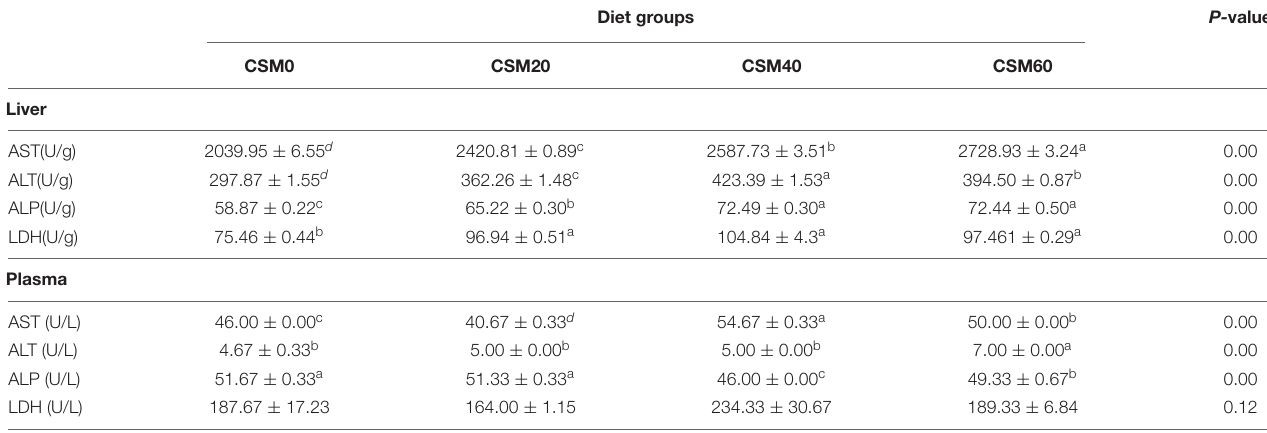
TABLE 6 | The enzymes activities of golden pompano feed different experimental diets in the plasma and liver.